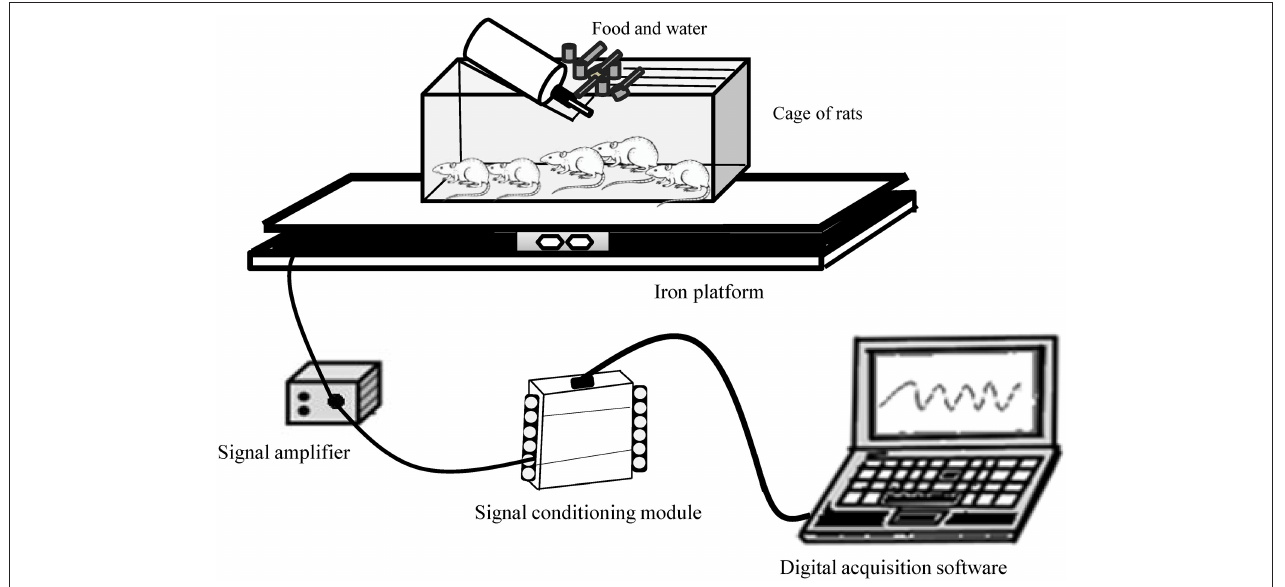
FIGURE 1 | Gravimetric apparatus for measuring spontaneous physical activity of